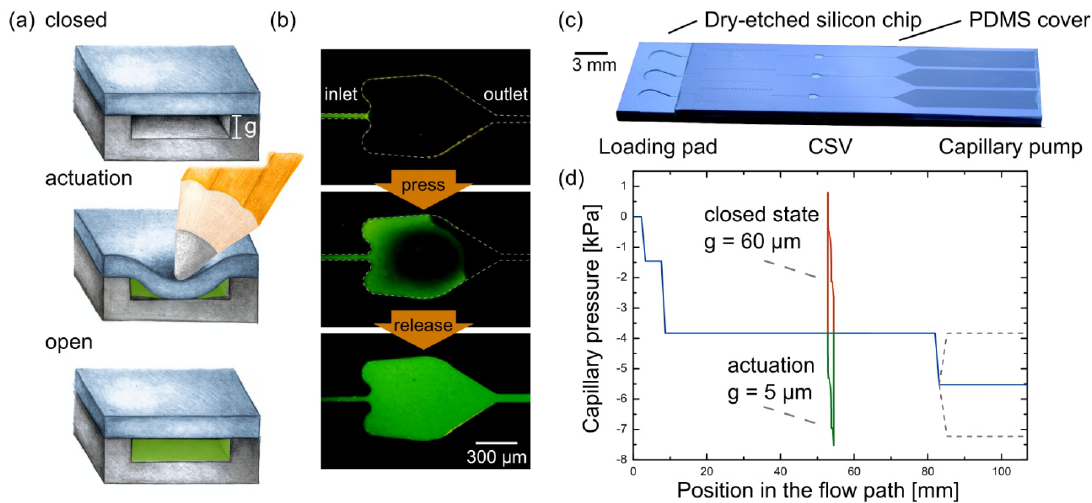
Figure 1. Capillary soft valves (CSVs). ( a ) Working principle of a CSV. ( b ) Fluorescence micrographs of a solution filling a CSV before, during and after actuation of the